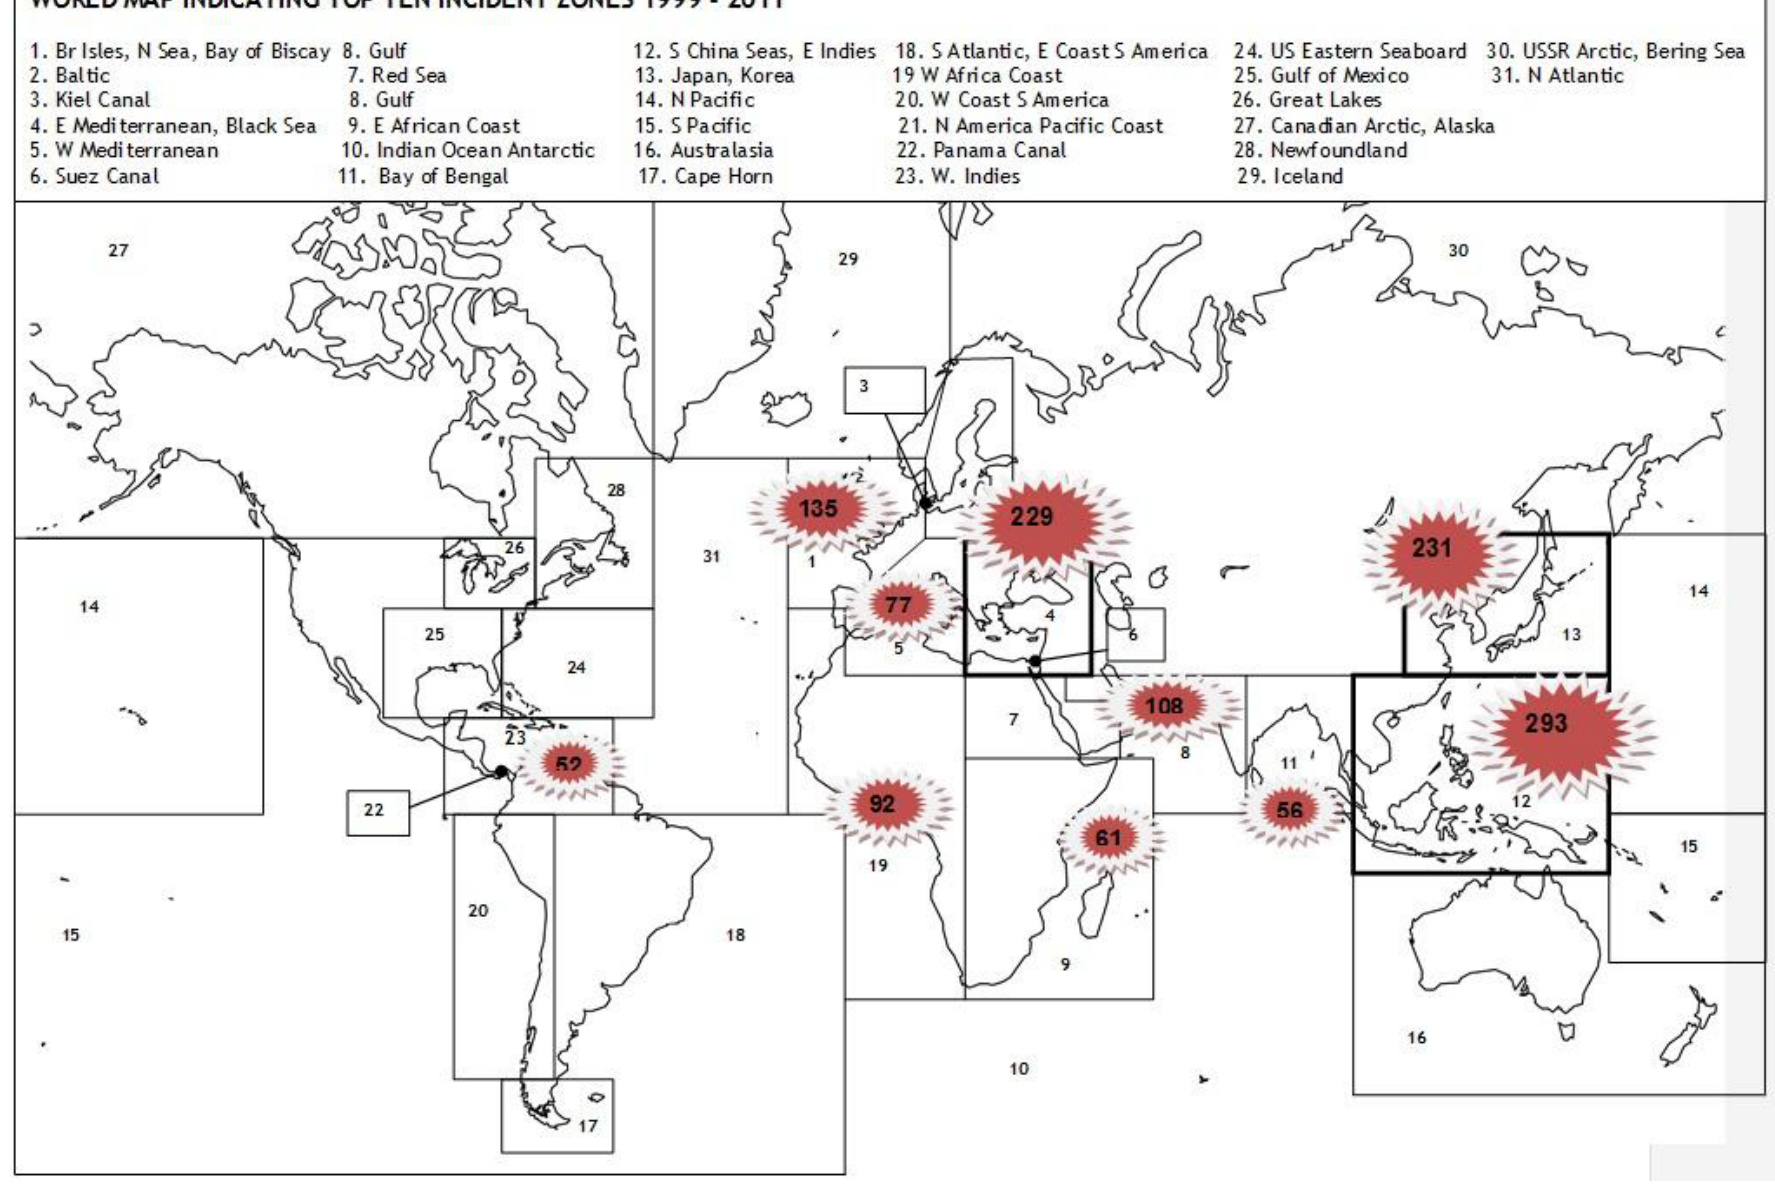
Figure 3 : World map indicating top ten incident zones